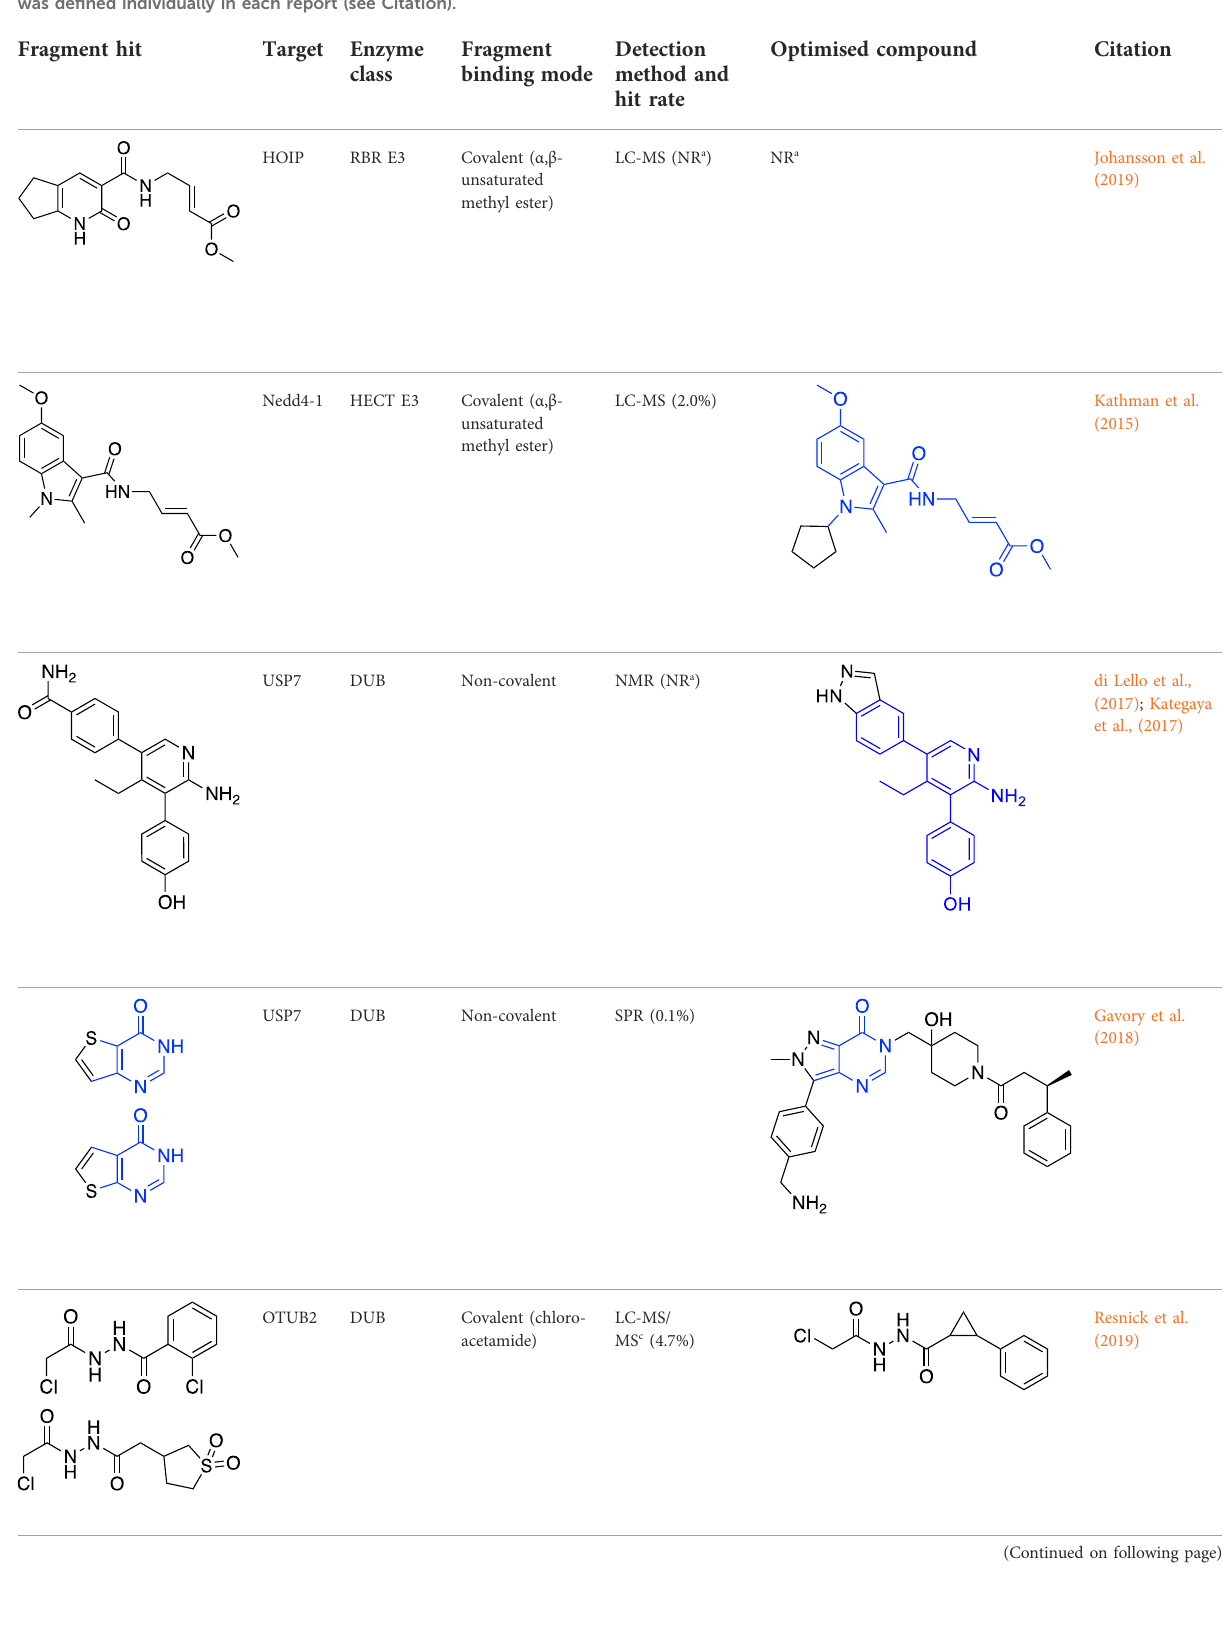
TABLE 1 ( Continued ) Summary of fragment hits and fragment-derived modulators of ubiquitin system proteins. Pharmacophores from original fragment hits which were retained in optimised compounds are highlighted in blue/green/purple. Potency/binding af fi nity of optimised compounds was de fi ned individually in each report (see